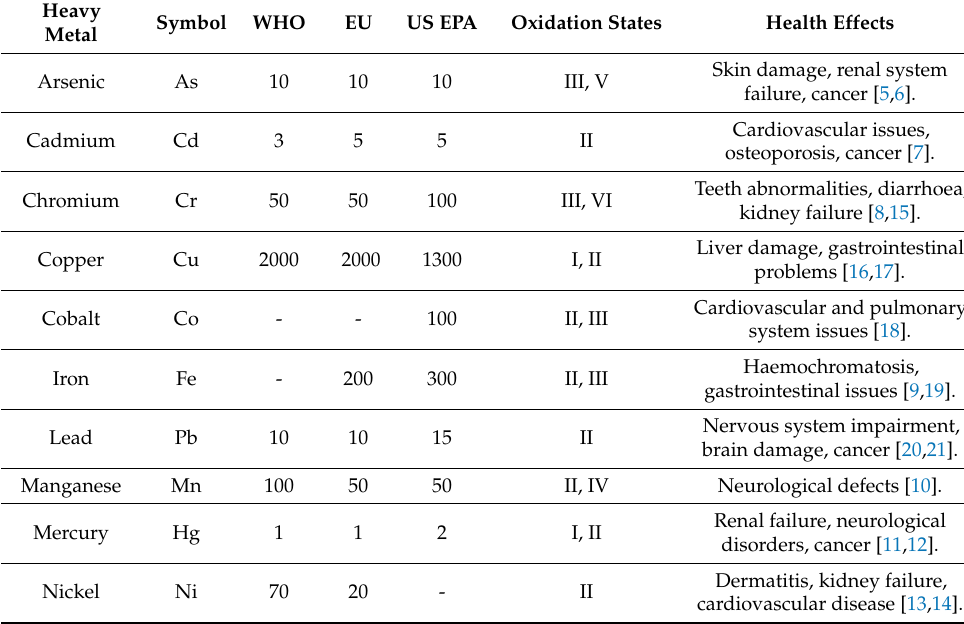
Table 2. Drinking water quality guidelines ( µ g L − 1 ) for heavy